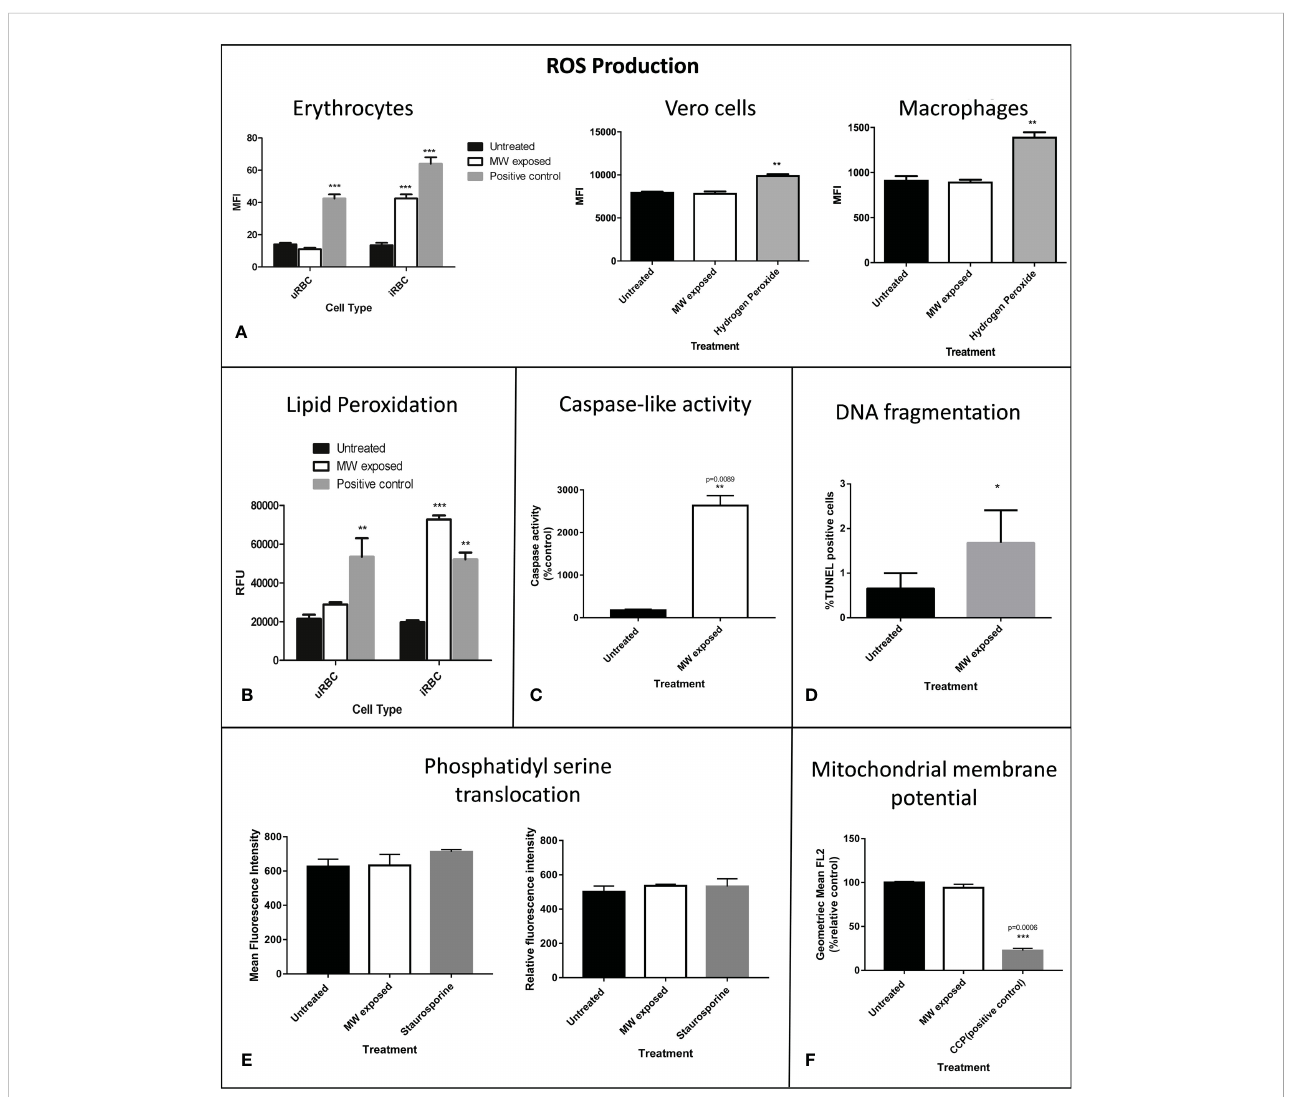
FIGURE 6 Molecular damage triggers apoptosis in MW exposed parasites. (A) ROS production of parasitized or uRBCs was assessed. Hydrogen peroxide was used as a positive control at a fi nal concentration of 200 m M. ROS production in Vero cells or in macrophages was analyzed after exposure to the same treatment as that of RBCs or iRBCs. Bars show the mean intensity fl uorescence of triplicates, of three experiments read in a fl uorometer. (B) Lipid peroxidation was detected through a Click-It LAA reaction. Cumene hydroperoxide at 100 uM was used as a positive control. Bars show the relative fl uorescence units of triplicates of one representative experiment out of three read in a fl uorometer. (C) Caspase-like activity measured through fl ow cytometry. Data are expressed as % of control and are the means of duplicates, n=3. (D) DNA fragmentation was quanti fi ed by fl ow cytometry 24 hours after MW treatment. Experiments were run in triplicates, n=3. Data are the means ± SEM. (E) Level of phosphatidylserine externalization after MW irradiation on uRBC (left) or iRBCs (right) using an Annexin V assay to measure its level. Staurosporine was used as positive controls for phosphatidylserine externalization. Data are the means of n=3 ± SEM. (F) The mitochondrial membrane potential was measured through fl ow cytometry measurement of red JC-1 fl uorescence which correlates with the mitochondrial membrane potential DY m. Bar graphs show the geometric mean of FL2 (red fl uorescence) using 50 µM CCCP as positive control for mitochondrial membrane depolarization. Data are the mean of n=3 ± SEM. Two-way ANOVA analysis was used in (A) and (B) and one-way ANOVA was used in (C-F). *p<0.05, **p<0.01,